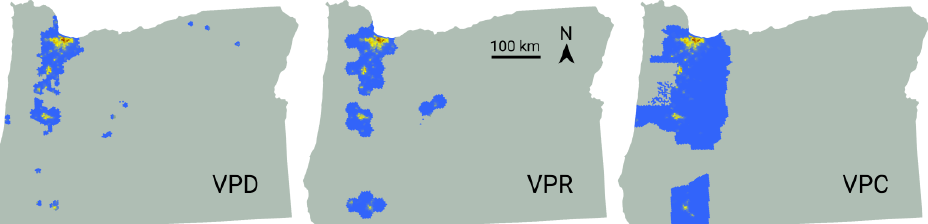
Figure 6. Spatial vaccination strategies emerging from one replicate each of the VPD, VPR, and VPC models. The number of individuals vaccinated is indicated by color, with lower numbers shown in blue, intermediate values in yellow, and the largest numbers in red.